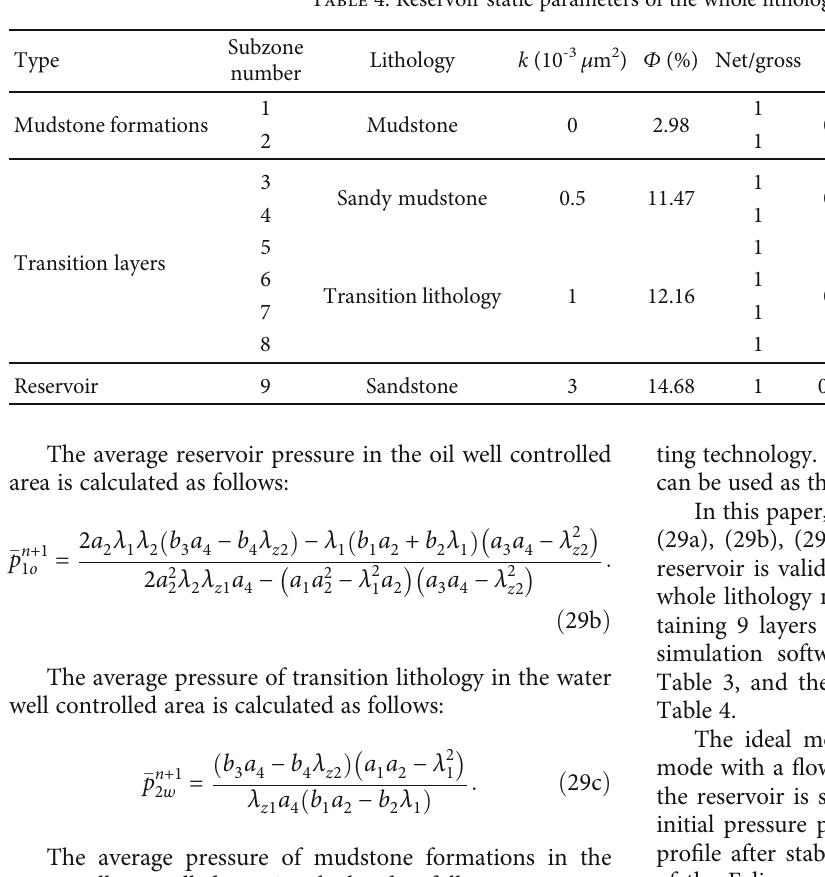
Table 4: Reservoir static parameters of the whole lithology ideal